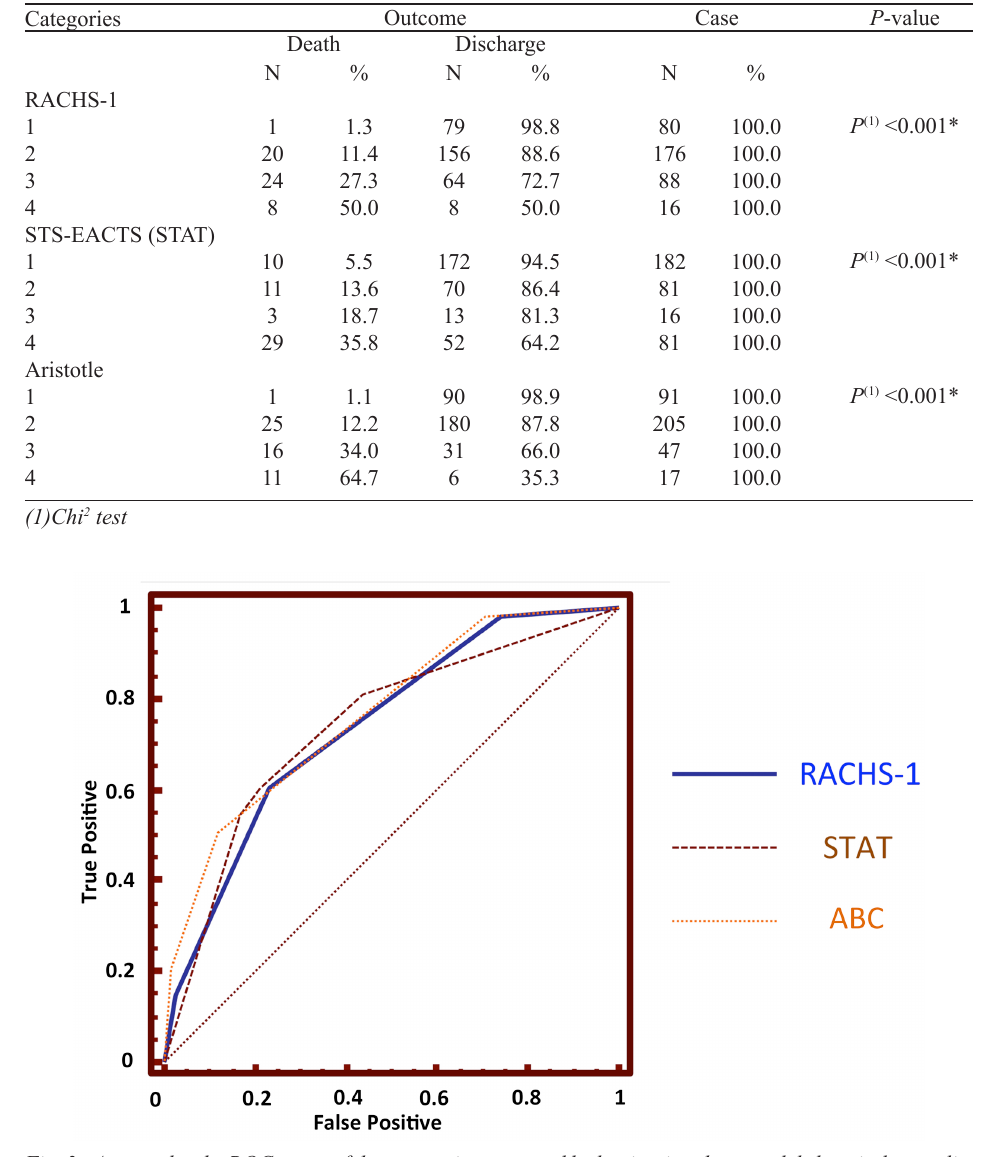
Fig. 3 - Area under the ROC curve of the categories proposed by laminating three models hospital mortality as the endpoint. Graph of the ROC curves (Receiver Operating Characteristic) for the three models plotted with different colors. Observe the superposition of three curves.